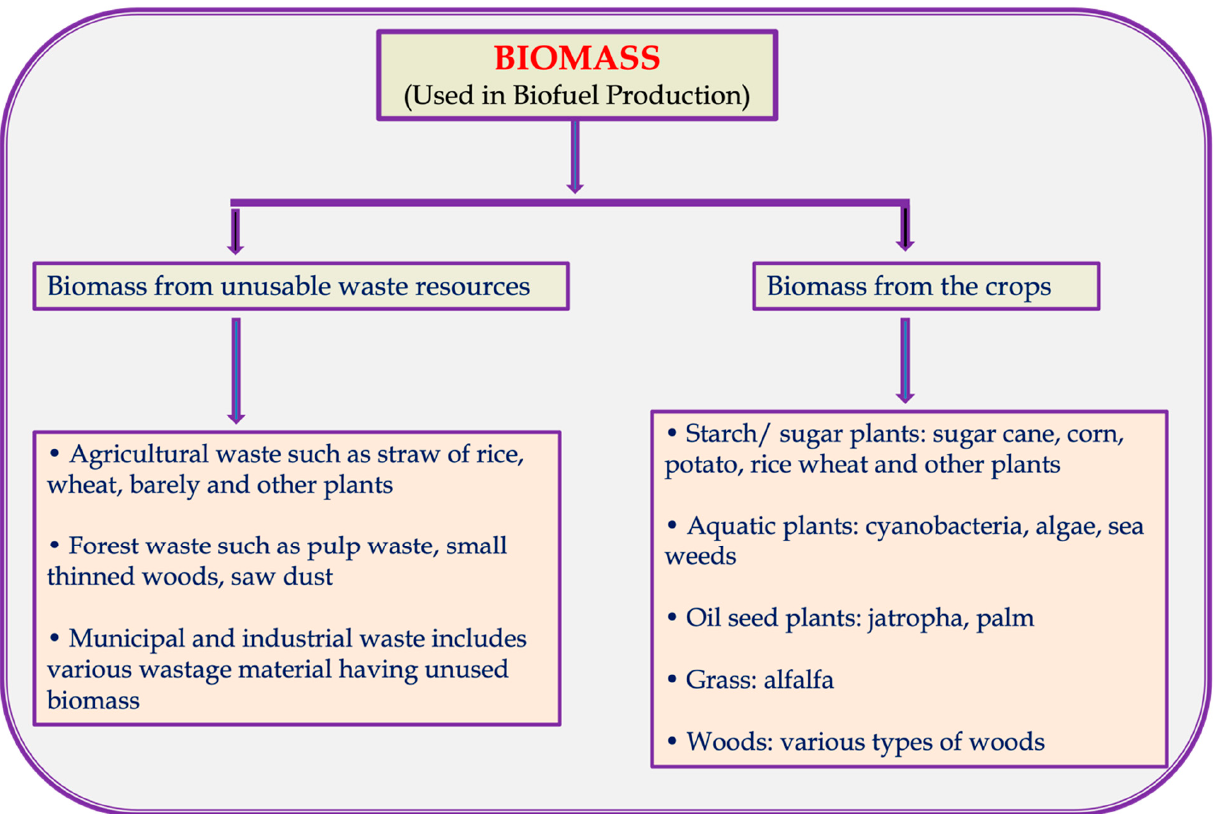
Figure 2. Biomass used as a renewable resource for biofuel production (adopted and modified from Naik et al. [13].)